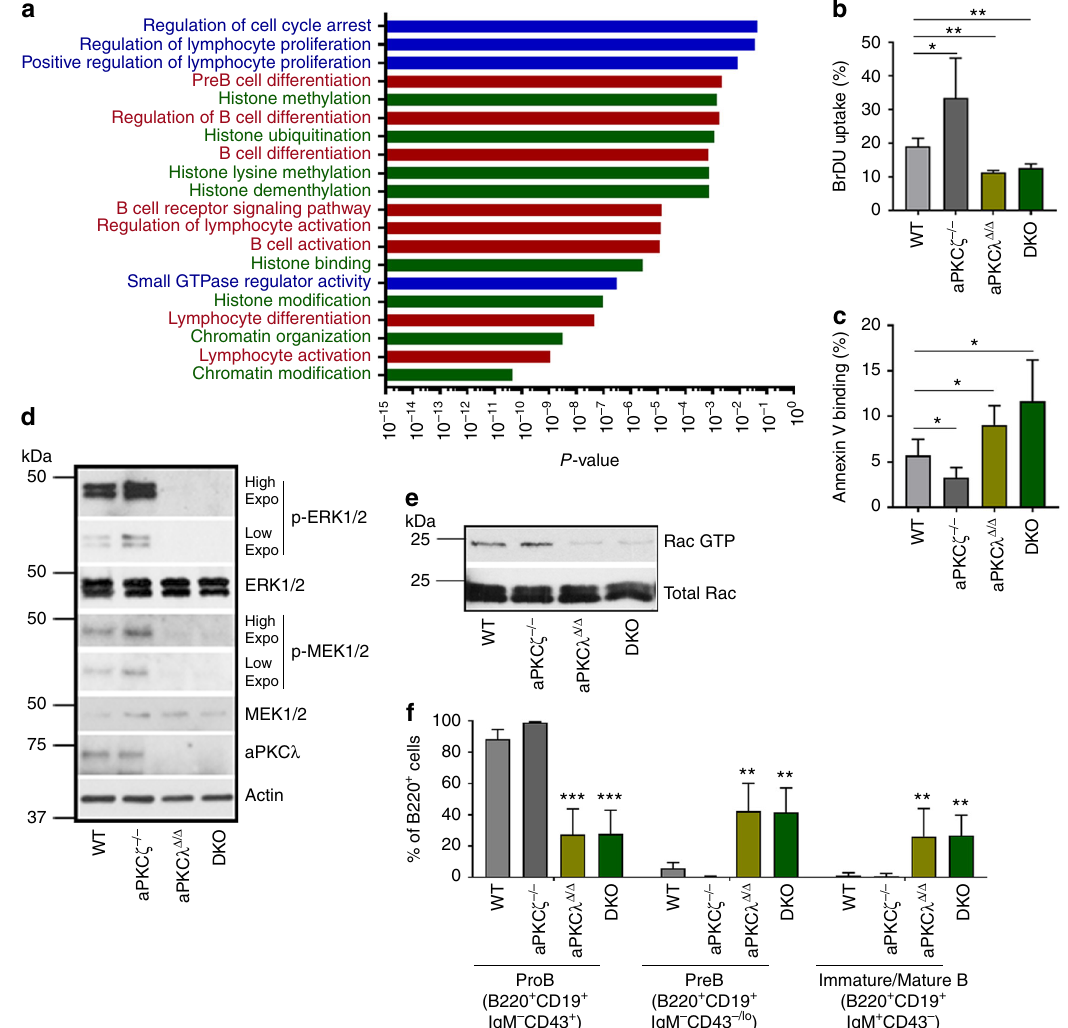
Fig. 3 aPKC λ de fi ciency impairs proliferation, survival and B cell differentiation arrest. a Comparative transcriptome and gene-ontology (GO) pathway analyses of the differential expression of genes in WT and DKO leukemic B-cell progenitors showing the differential regulation of genes involved in proliferation, cell cycle regulation, B cell differentiation network, and histone and chromatin modi fi cations. Pathways shown in Blue - proliferation and cell cycle regulation; in Red - B cell differentiation network; in Green - histone and chromatin modi fi cation. b In vivo BrDU uptake by leukemic B-cell progenitors in Scl/P210; WT, aPKC ζ − / − , aPKC λ Δ / Δ , and DKO chimeric mice. c FACS quanti fi cation of annexin V-binding of WT, aPKC ζ − / − , aPKC λ Δ / Δ and DKO leukemic B-cell progenitors. d Representative example of western blots of p-ERK1/2, ERK1/2, p-MEK1/2, MEK1/2, aPKC λ , and Actin in WT, aPKC ζ − / − , aPKC λ Δ / Δ , and DKO leukemic B-cell progenitors. Activation of MEK/ERK MAPK pathway is impaired in aPKC λ de fi cient leukemic B-cell progenitors. Western blots with different exposure time for phospho-Erk1/2 and phospho-Mek1/2 were presented to show minimal expression; Low (15sec), high (1min). e Representative example of the analyses of Rac GTPase activation by speci fi c effector pulldown (PAK-PBD agarose) assay in leukemic B-cell progenitors derived from WT, aPKC ζ − / − , aPKC λ Δ / Δ and DKO chimeric mice. f FACS-quanti fi cation of proB, preB and immature/mature B cells in the BM of WT, aPKC ζ − / − , aPKC λ Δ / Δ and DKO chimeric mice. Data are presented as mean ± SD of a minimum of three independent experiments. * p < 0.05; ** p < 0.01; *** p < 0.001, t